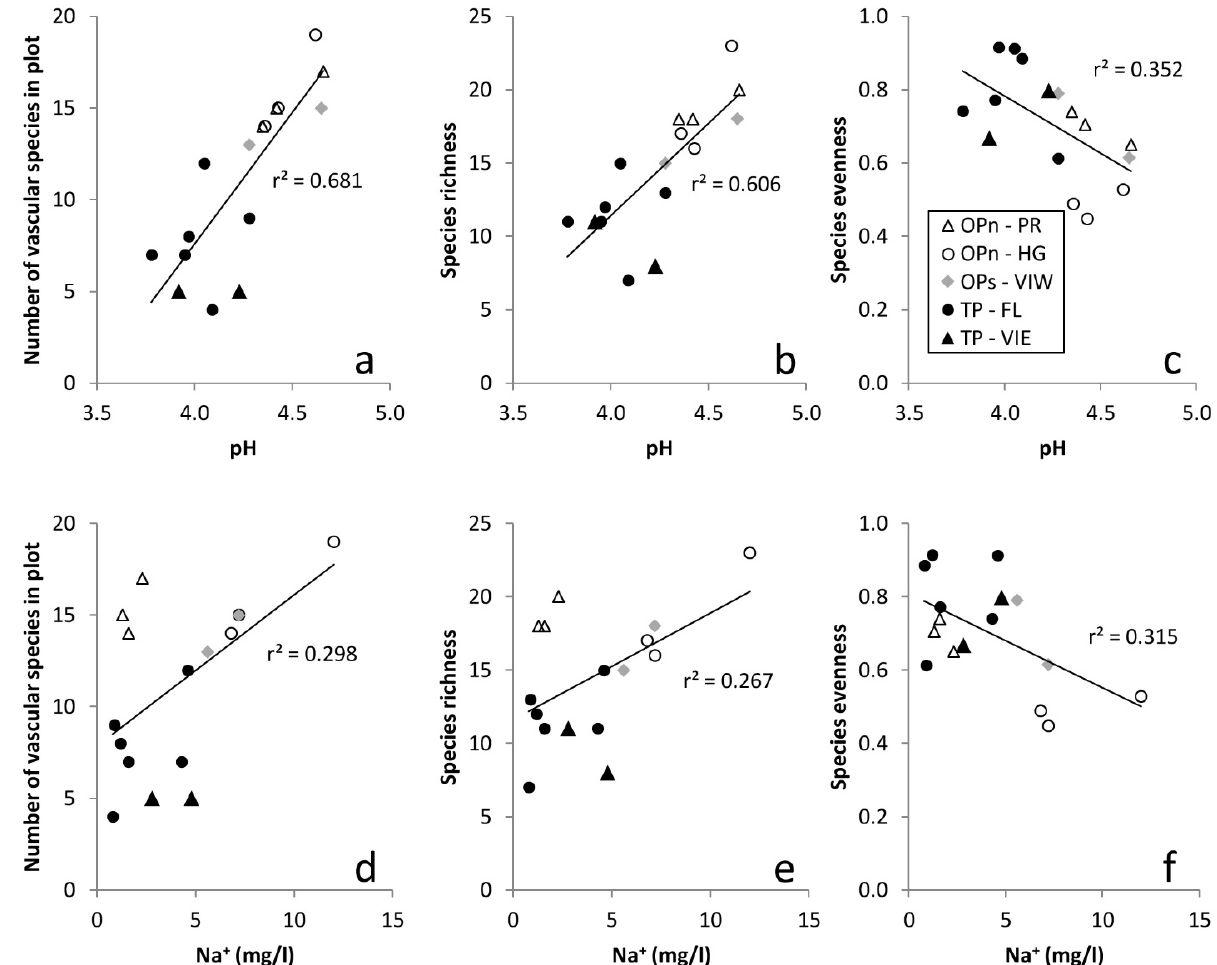
Figure 5. Significant linear regressions ( P < 0.05) between the number of vascular plant species (left column), species richness (middle column) or species evenness (right column), and pH (top row) or Na + concentration in pore water (bottom row), in BG plots. OPn = Pacific Oceanic wetland region, North Coast subregion; OPs = Pacific Oceanic wetland region, South Coast subregion; TP = Pacific Temperate wetland region; PR = Prince Rupert; HG = Haida Gwaii; VIW = west coast of Vancouver Island; VIE = east coast of Vancouver Island; FL = Fraser